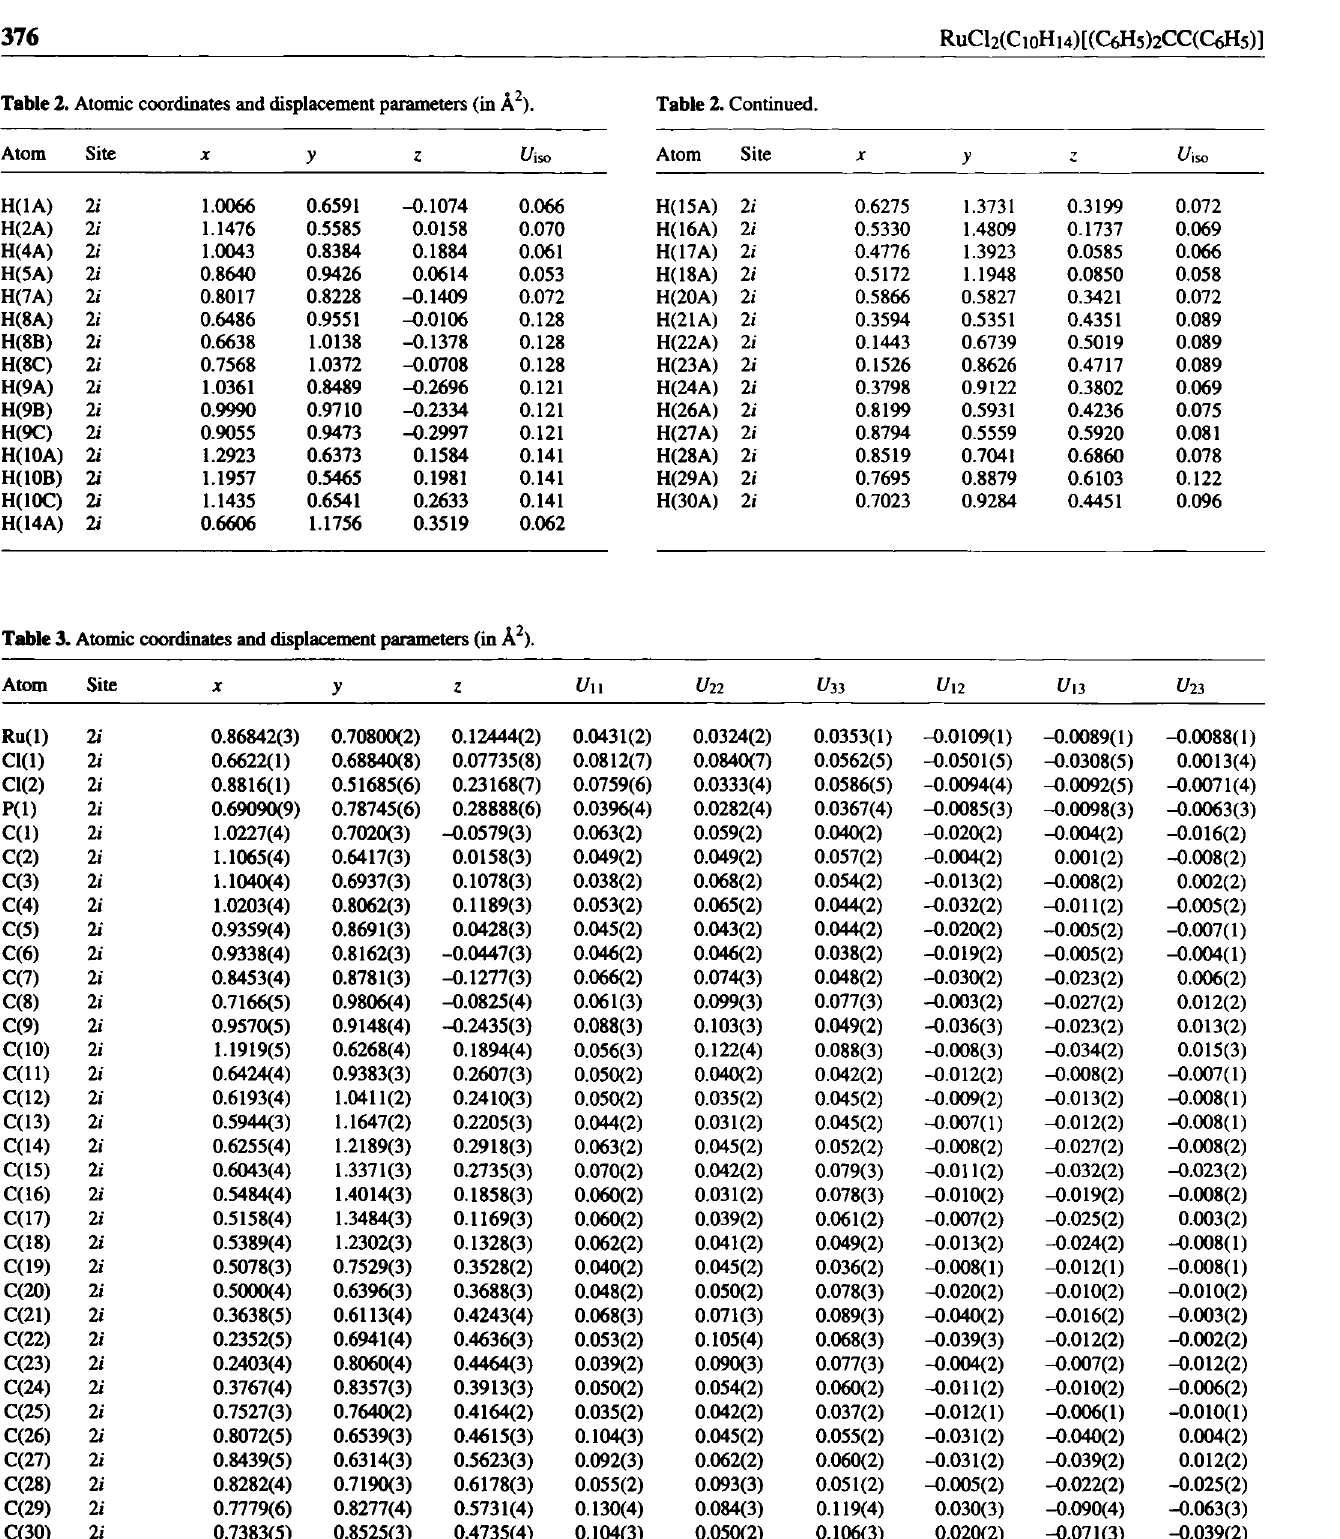
Table 2. Atomic coordinates and displacement parameters (in Â 2 ). Table 2. Continued.